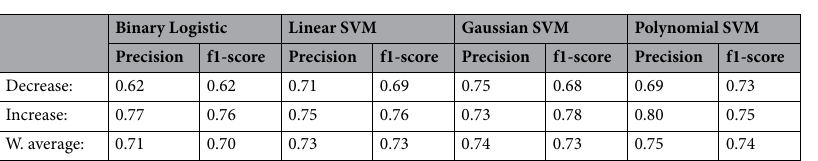
Table 1. Classification performance of the multiple logistic regression and the tested SVM classifiers on the NF and TF changes. The precision is the ratio of correct classification, which was computed for each answer and as the weighted average. The f1-score is defined as the harmonic mean of precision and recall.